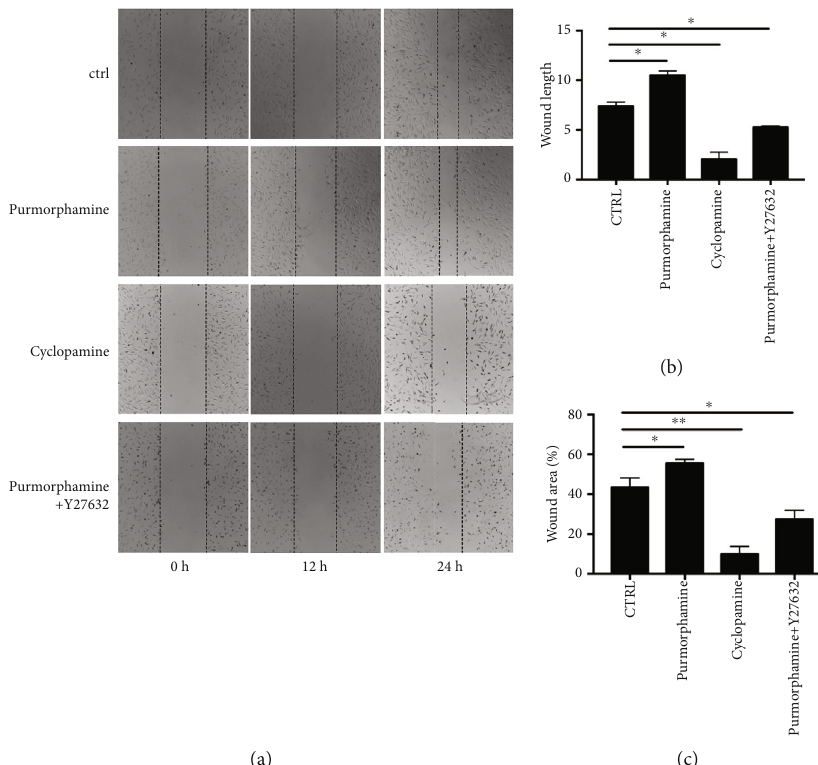
Figure 6: Shh signaling regulates RA-FLS migration via the Rho/ROCK pathway, revealed by wound healing assays. (a) In the Transwell assay, the numbers of migrated RA-FLS were higher in the treatment of purmorphamine; after RA-FLS treating with cyclopamine or purmorphamine combined with Y27632, the numbers of migrated cells were both decreased. (b) After 24 h, the wound healing duration of RA-FLS was increased as a result of purmorphamine treatment, while treated with cyclopamine or a combination of Purmorphamine and Y27632, it was decreased. (c) The wound healing area of RA-FLS in the treatment of purmorphamine was increased after 24h, while it was decreased after treating with cyclopamine or a combination of purmorphamine for 24h. ∗ p < 0 : 05 , ∗∗ p < 0 : 01